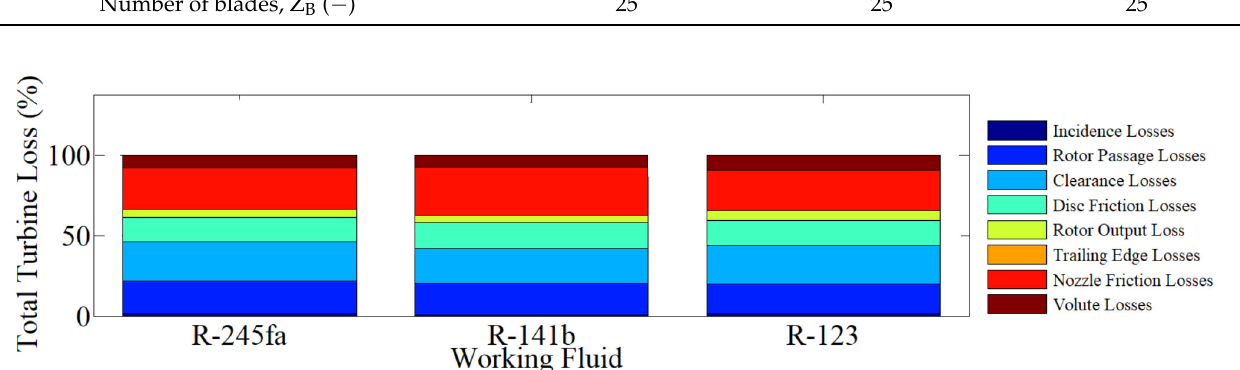
Figure 8. Losses in radial turbines operating with different working fluids. The results shown in Figure 8 highlight that, for radial inflow turbine designs, the greatest losses occur at the nozzle, clearances, and rotor passage. For the three radial inflow turbine configurations, the lowest losses occur at the channel outlet, volute, and disc (friction). These results show the high impact that the nozzle design has on the working fluid and its flow regime along this component and its transition to the rotor. Another important aspect to verify is the spacing between the turbine components to avoid